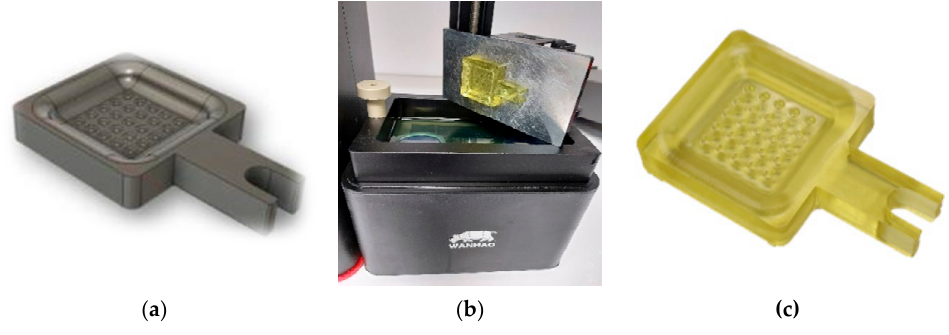
Figure 2. Functional model. ( a ) Modelling ( b ) Manufacturing. ( c ) Result.